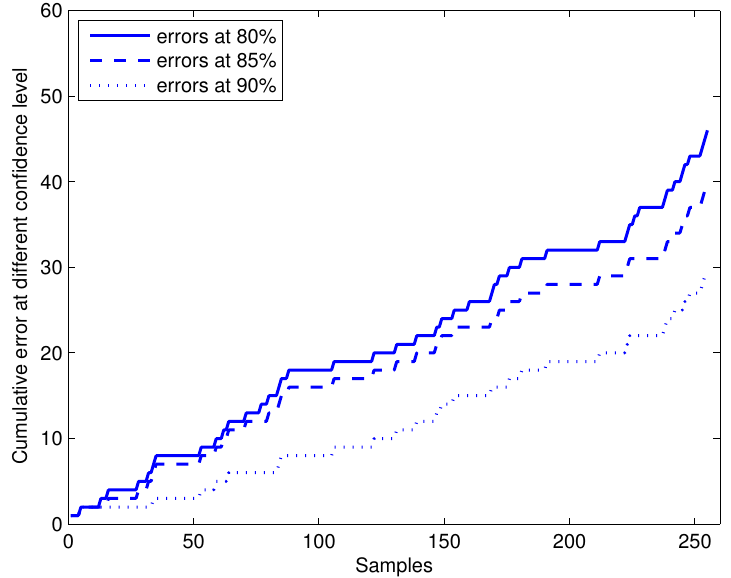
Figure 5. The cumulative errors of online prediction with CP-1NN (conformal prediction based on 1NN) at confidence levels of 80%, 85% and